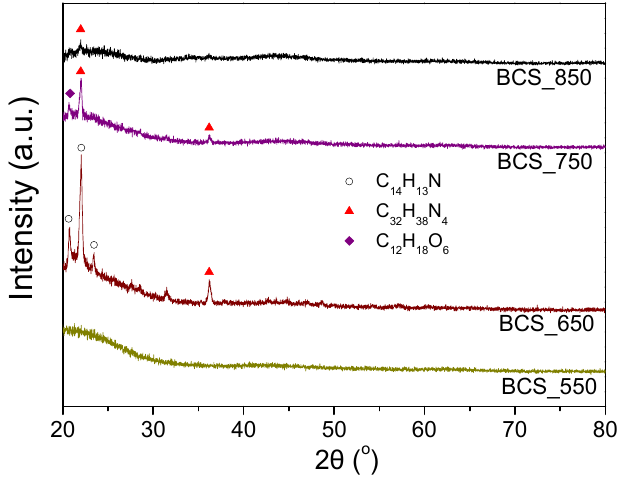
Figure 1. XRD patterns of biochar samples derived from sawdust (BCS) heat-treated at different temperatures.